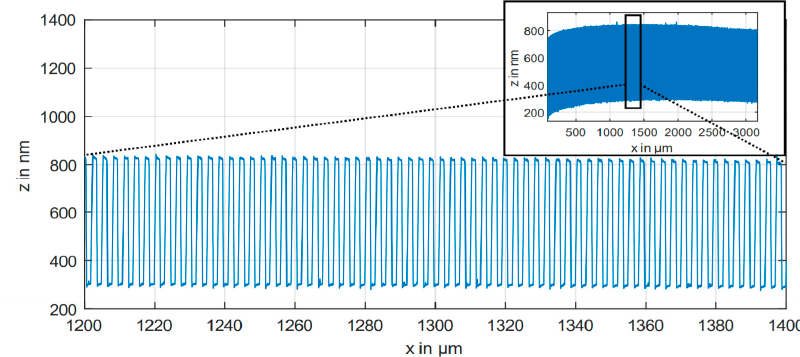
Figure 1. Line scan of 3 mm with a count of 1000 pitches and section (200 µm in length) of the